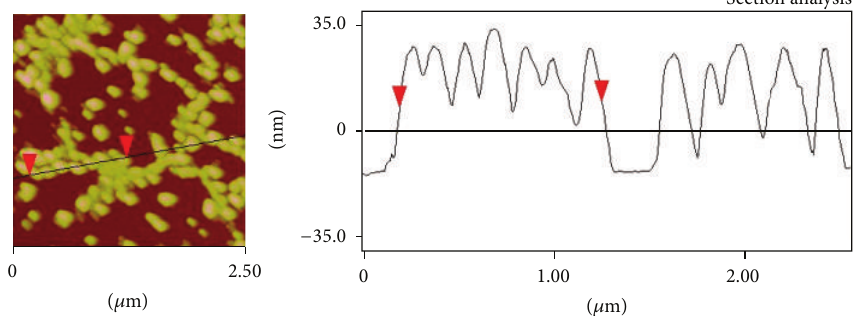
Figure 10: Section analysis of DPG after high-temperature aging.